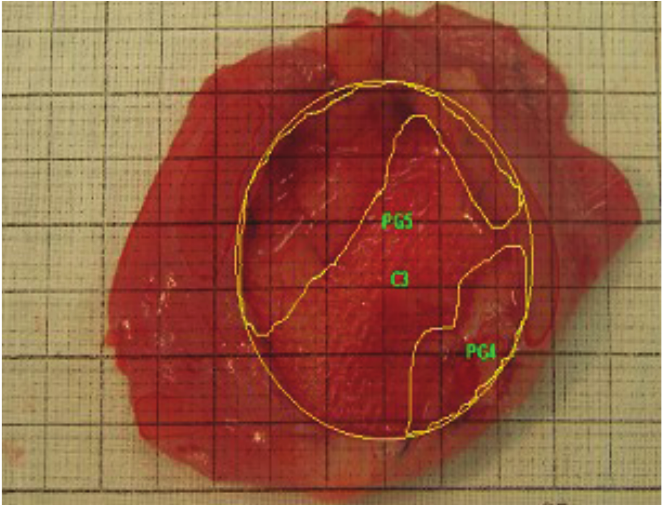
FIGURE 2 - The irregular area inside the circle delineates a peritoneal surface covered by adhesions.